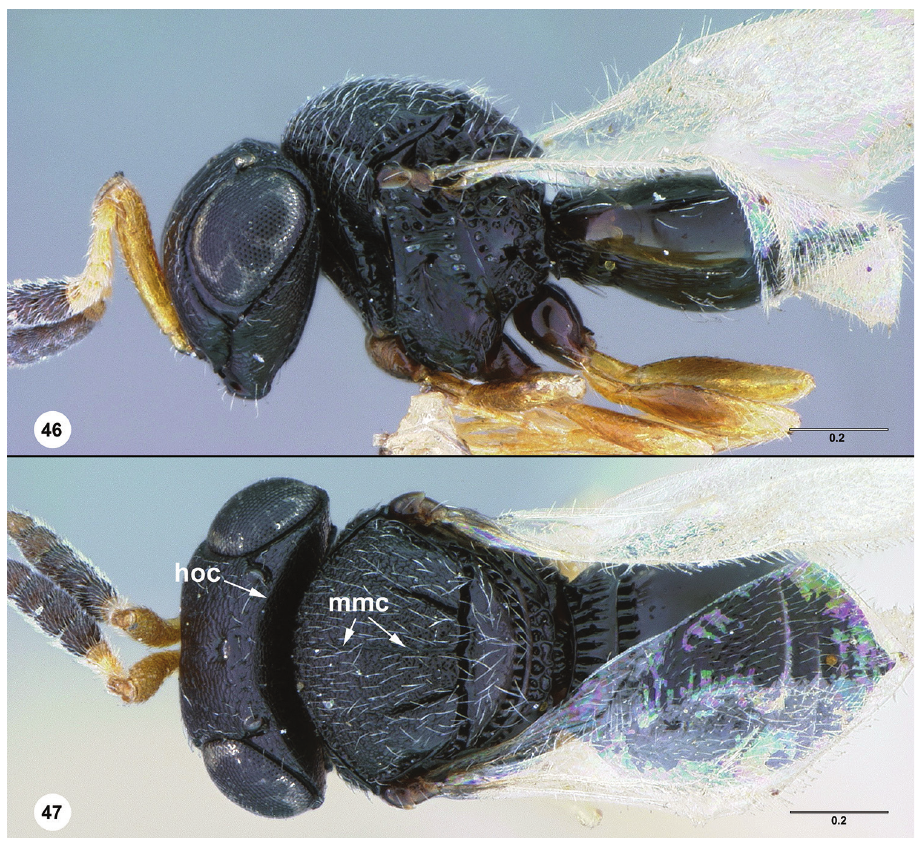
Figures 46–47. Trissolcus edessae , female (USNMENT00916178) 46 head, mesosoma, metasoma, lateral view 47 head, mesosoma, metasoma, dorsal view. Scale bars in millimeters. Head. Color of radicle: yellow. Length of radicle: less than width of clypeus. Color of A1–A6 in female: yellow. Color of A7–A11 in female: brown. Number of basiconic sensilla on A6: 0. Number of basiconic sensilla on A7: 2. Facial striae: absent. Number of clypeal setae: 2. Microsculpture on gena directly above mandibular condyle: present. Shape of ventral gena in lateral view: narrow. Genal carina: absent. Malar striae: absent. Sculpture of malar sulcus: faintly rugulose. Orbital furrow: expanding in size ventrally, strongly so at intersection with malar sulcus. Macrosculpture of frons between anten- nal scrobe and anterior ocellus: transversely strigose ventrally, absent dorsally. Preocel- lar pit: present. Setation of lateral frons: moderately dense. Punctation of lateral frons: sparse. Sculpture directly ventral to preocellar pit: microsculptured. Macrosculpture of lateral frons: absent. OOL: separated by less than one ocellar diameter. Hyperoccipital carina: complete. Macrosculpture of posterior vertex: absent. Anterior margin of oc- cipital carina: coarsely